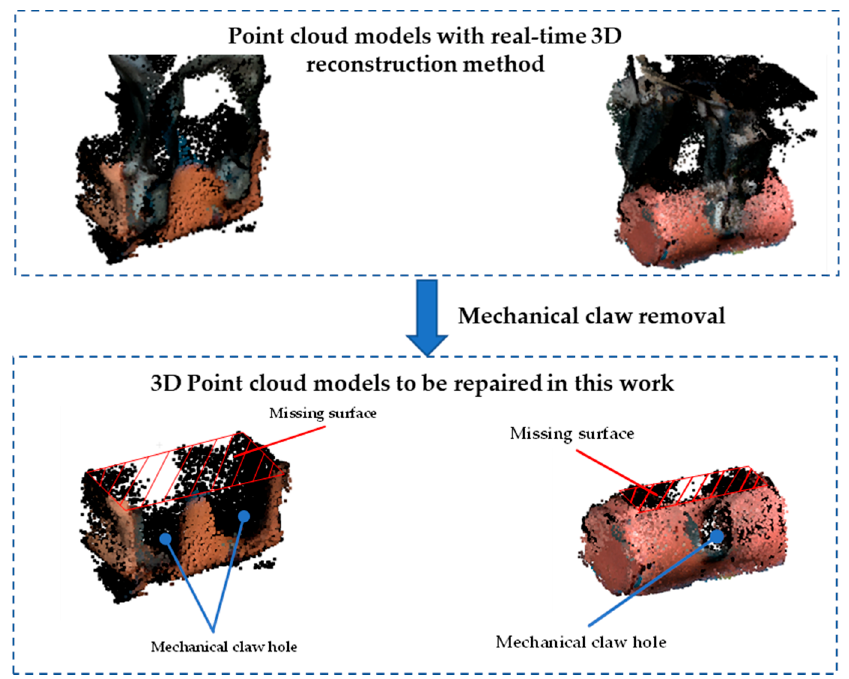
Figure 1. Examples of real-acquired 3D point cloud models repaired in this paper; the removal of the mechanical claw produces holes on the side of the point cloud; the limited imaging angle in 3D reconstruction results in a large missing surface at the top of the point cloud.